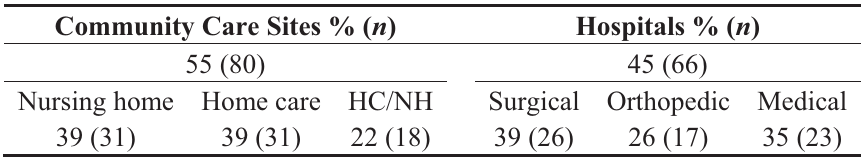
Table 1. Population by care